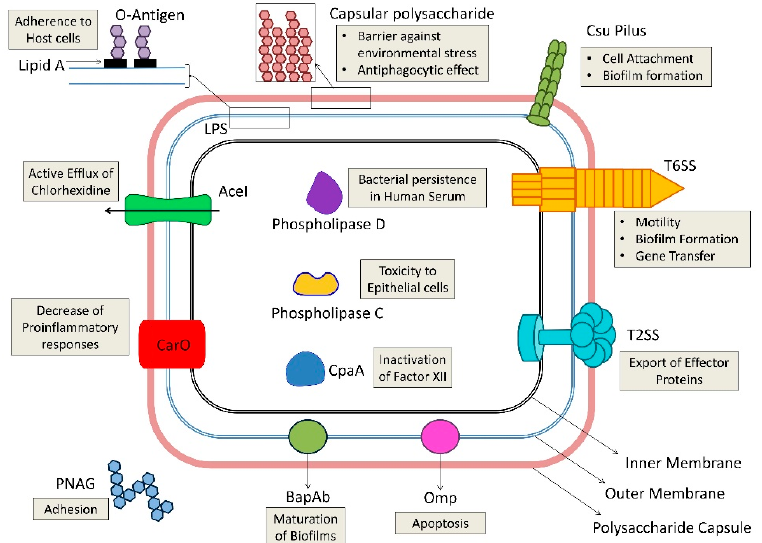
Figure 2. An illustration of virulence determinants possessed by Acinetobacter baumannii . The function of each determinant is shown in the adjacent box. AceI = Acinetobacter chlorhexidine efflux protein; CpaA = glycan-specific adamalysin-like protease; Csu = chaperon/usher pilus system; LPS = lipopolysaccharide; Omp = outer membrane protein; PNAG = poly- β -1,6-N-acetylglucosamine; T2SS = type II secretion system; T6SS = type VI secretion system.